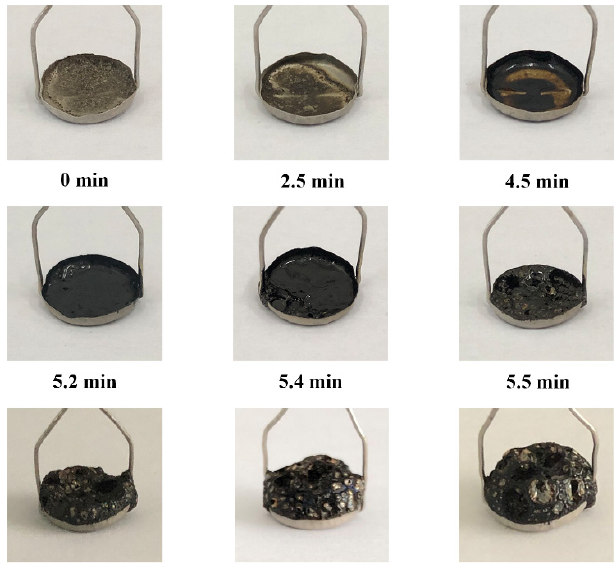
Figure 1. Images of sodium phenolates with time at 495 °C .